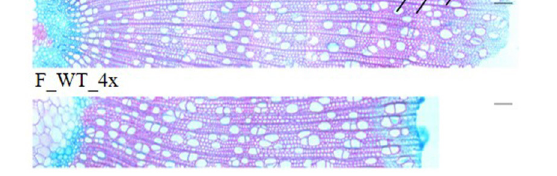
FIGURE6 Stem anatomy of field-grown di- and tetraploid poplar trees. The main stem of field-grown WT trees was harvested 1m above soil level in August 2017 of the second growth season. Transverse stem sections (from pith to bark) stained with astra blue, chrysiodine and acridine red are shown. Pictures are representative for the different independent lines. V, vessel; F, fiber; RC, ray cell. Scale bars = 100 µ m.